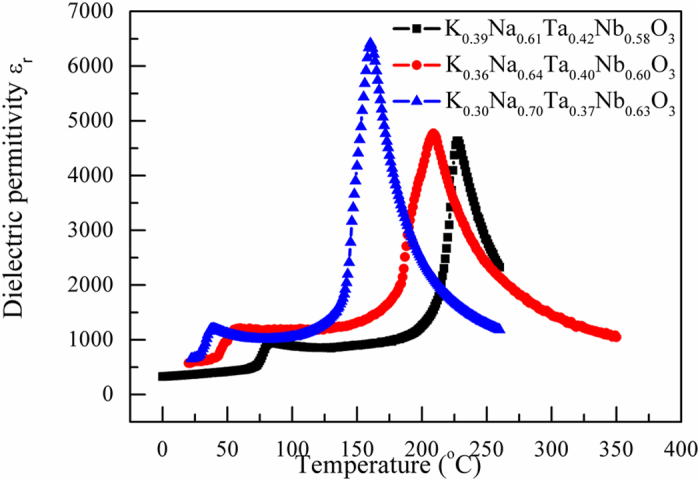
Temperature dependence of the dielectric constant of the K1−xNaxTa1−yNbyO3 crystals at 1 kHz.